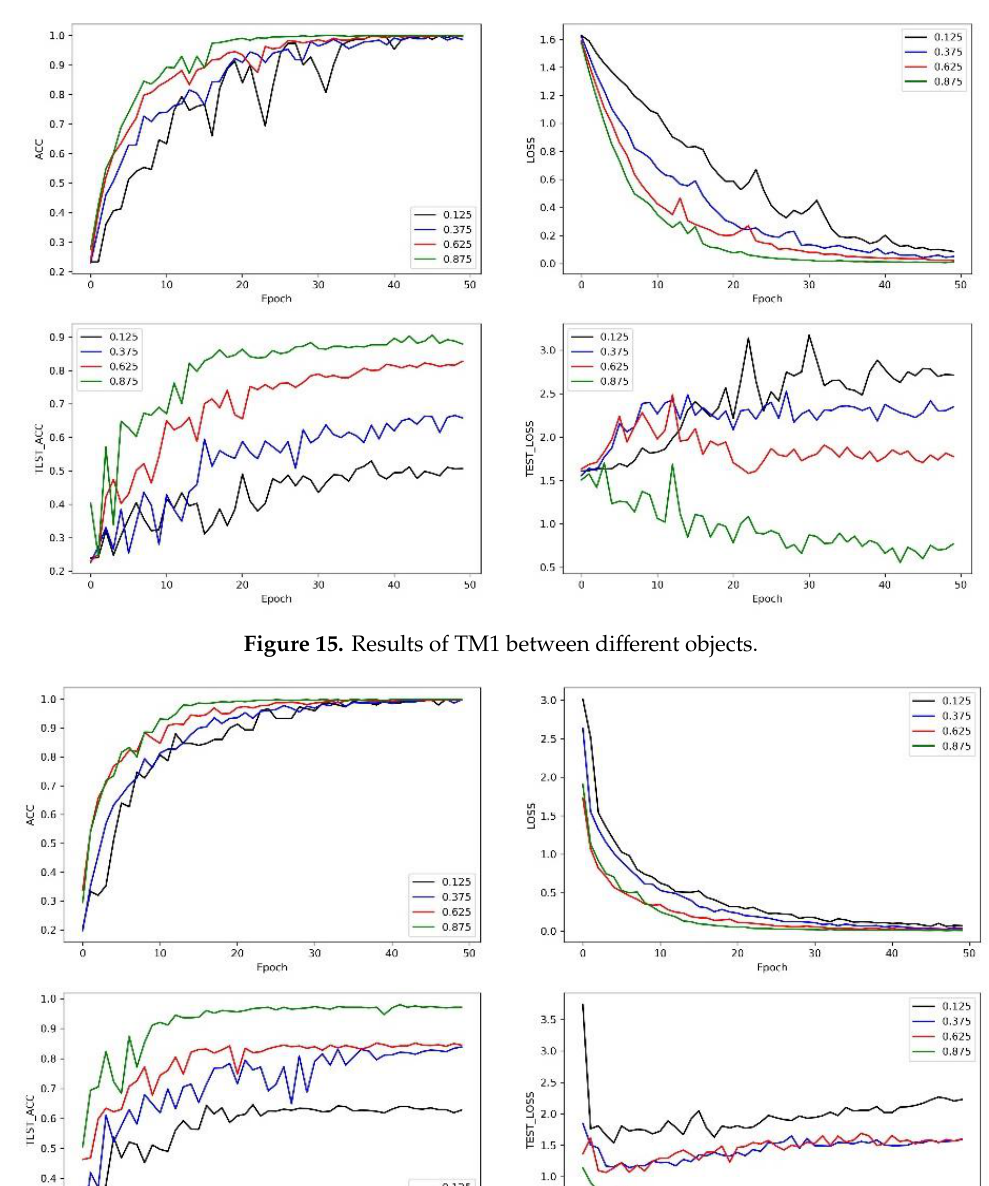
Figure 16. Results of TM2 between different objects.